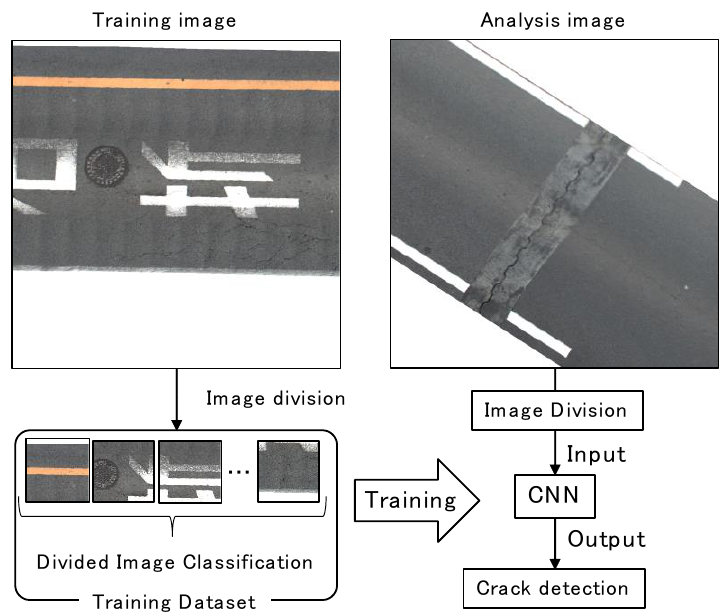
Figure 5. The flow of training and analysis with the CNN in this study. Table 1. Image classification.